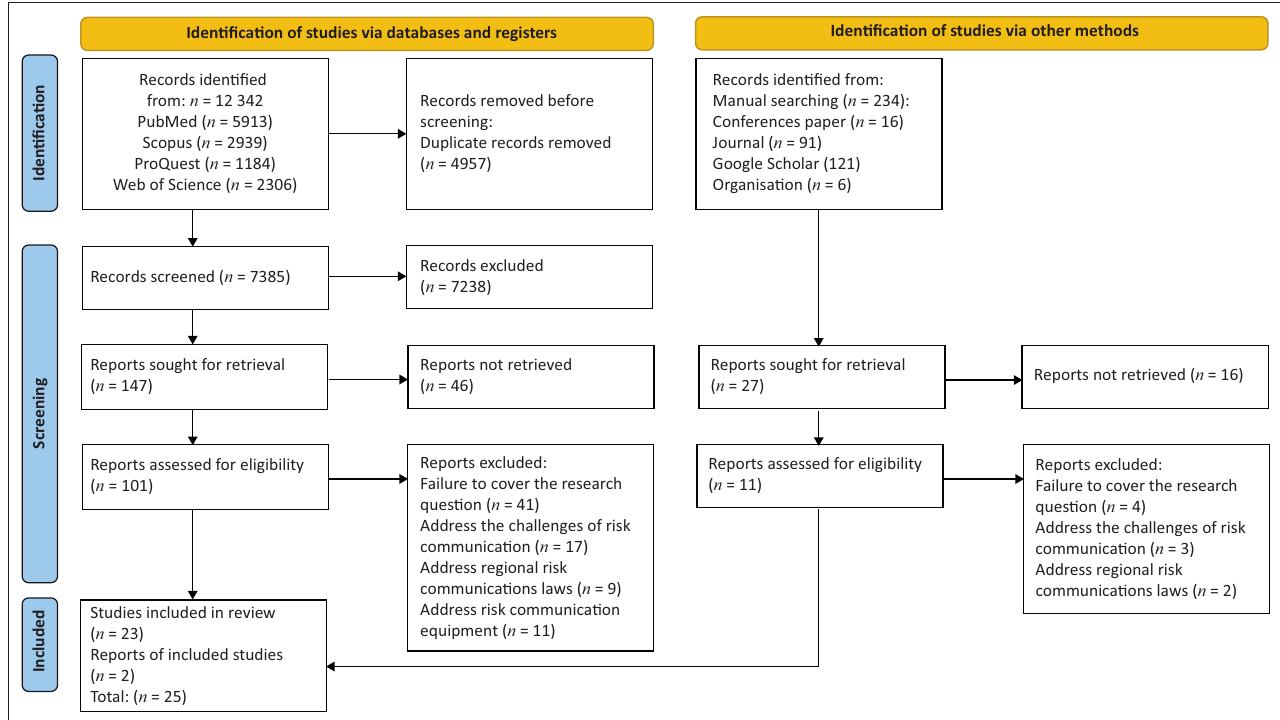
FIGURE 1: Preferred Reporting Items for Systematic Reviews and Meta-Analyses (PRISMA) chart 2020 systematic